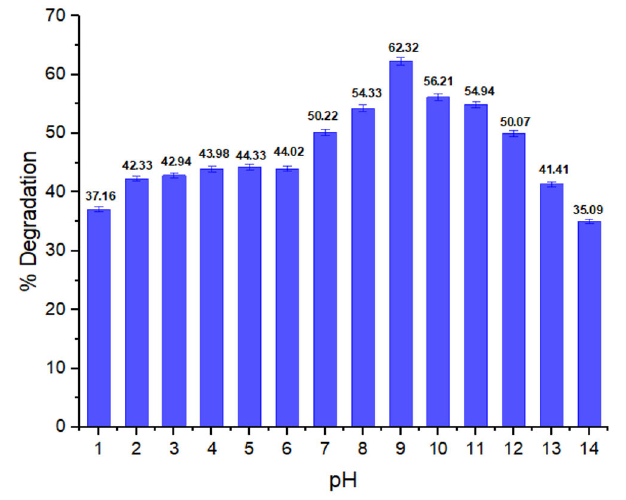
Figure 3. pH effect on % degradation of methyl red dye.